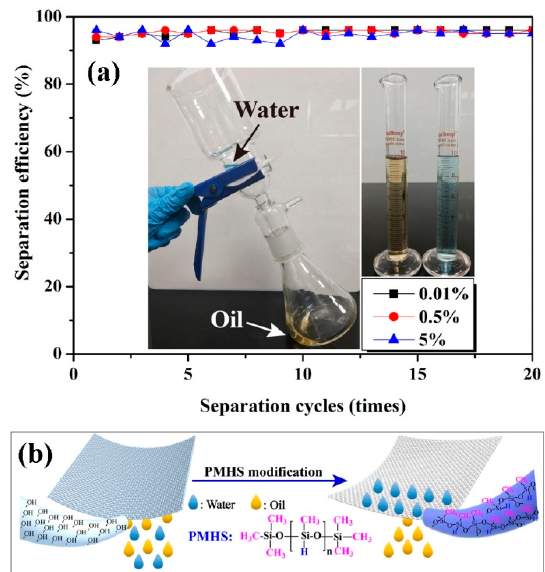
Figure 7. ( a ) Change in separation efficiency of diesel from water as a function of separation cycles (cotton fabrics were modified by modifier solution with PMHS concentrations of 0.01%, 0.5%, and 5%); ( b ) Chematical representation of oil/water seperation of PMHS-modified cotton fabric.